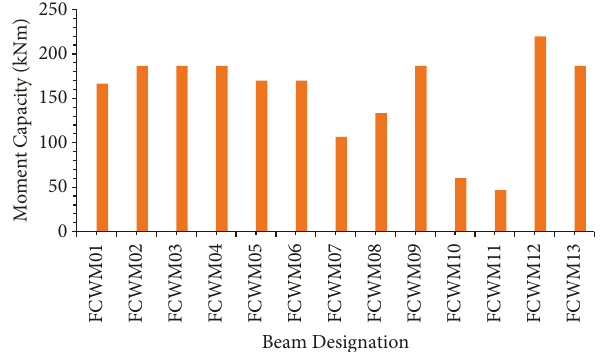
Figure 3: Moment capacity for different steel slag replacement and volume fraction of weld mesh ferrocement laminates.